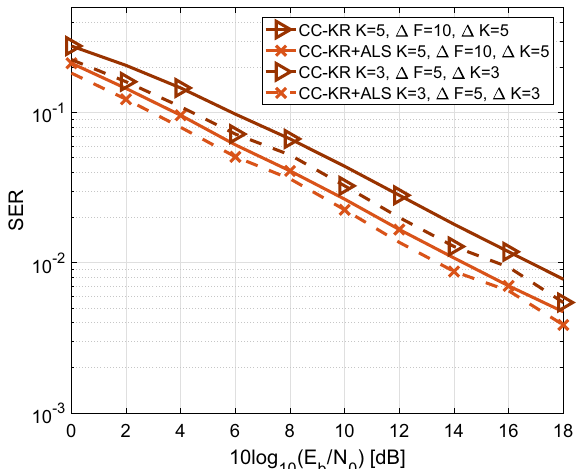
Fig. 6 SER for a 2 × 2 cross-coded OFDM system with parameters N = 128 , Q = 2 , K , (cid:31) K , (cid:31) F , and the symbols are drawn from a 4-QAM modulation. The parameters K , (cid:31) K and (cid:31) F are indicated in the